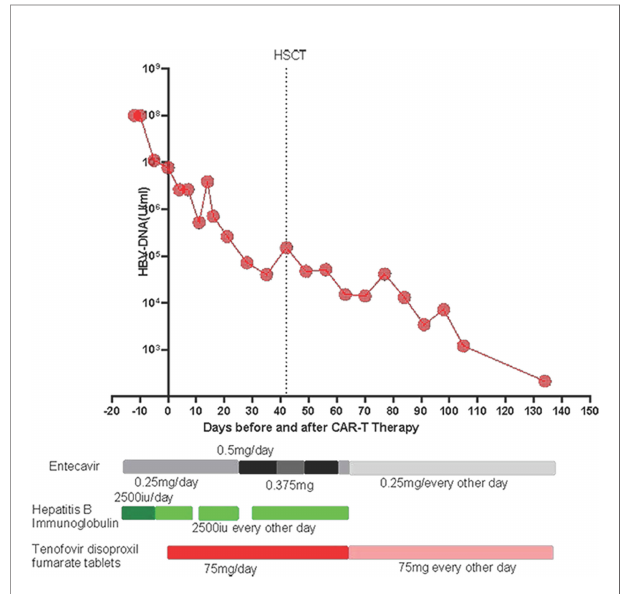
FIGURE 1 | Levels of HBV DNA during CD7 CAR-T therapy bridging to